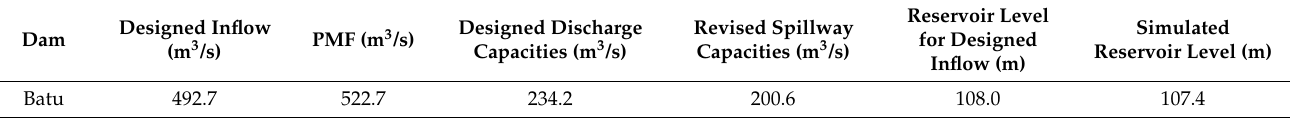
Table 4. Designed inflow and designed discharge capacities based on PMF